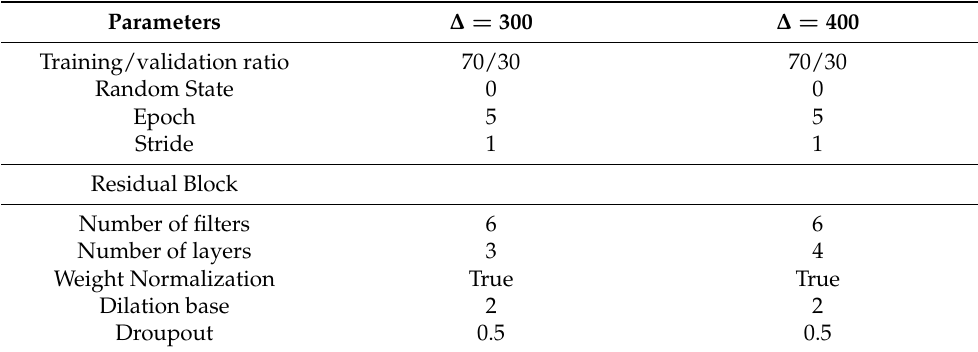
Table 3. TCN-TS-SW System